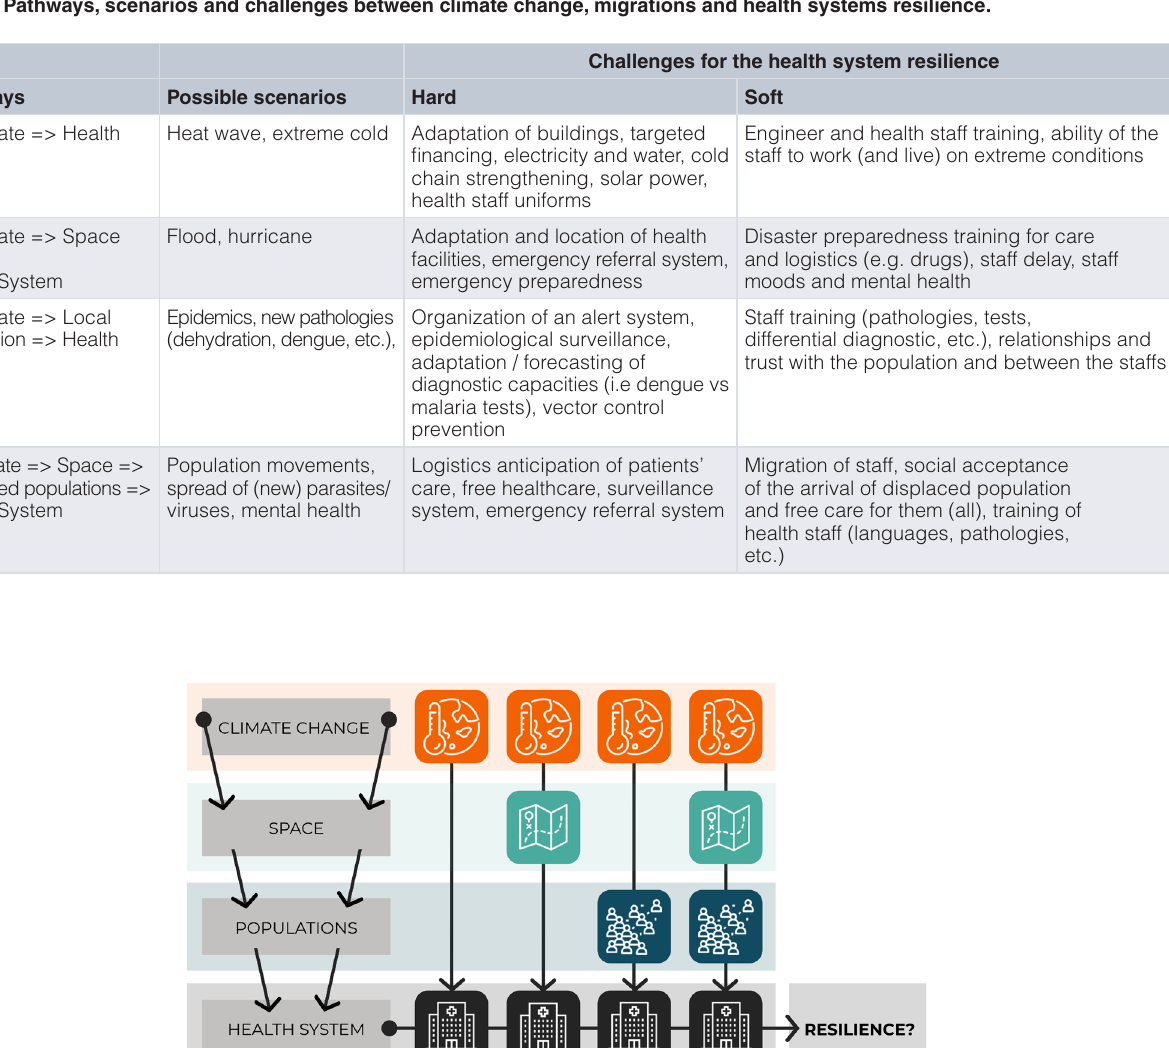
Table 1. Pathways, scenarios and challenges between climate change, migrations and health systems resilience.